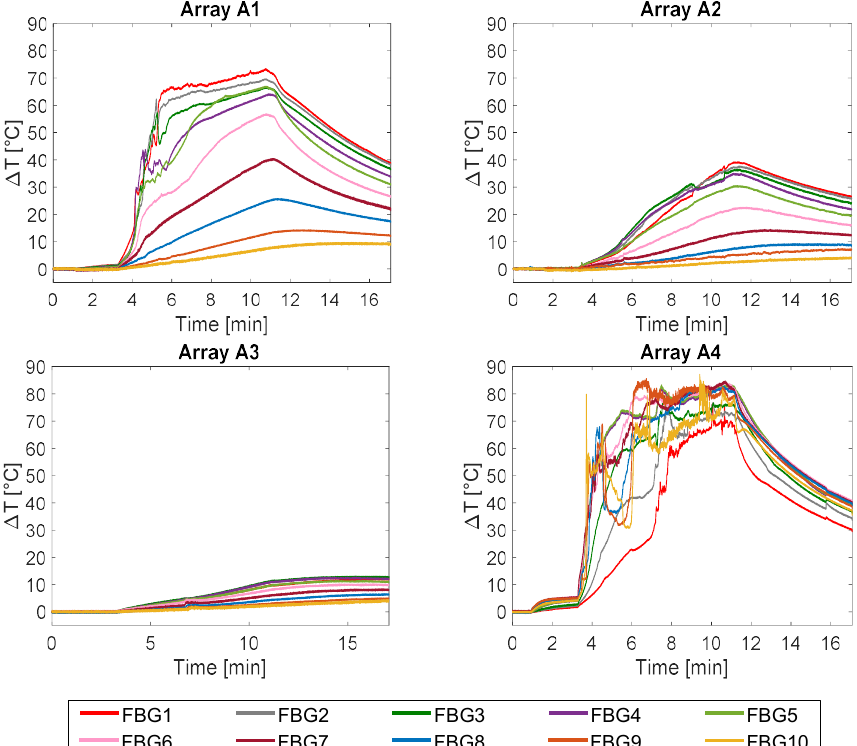
Figure 8. Temperature variations collected during the MW discharge and the cooling phase. The ten measurements recorded by the ten FBGs embedded in array A 1 and A 4 (both 5 mm far from the applicator), in array A 2 (10 mm far from the applicator), and in A 3 (15 mm far from the applicator) are shown.